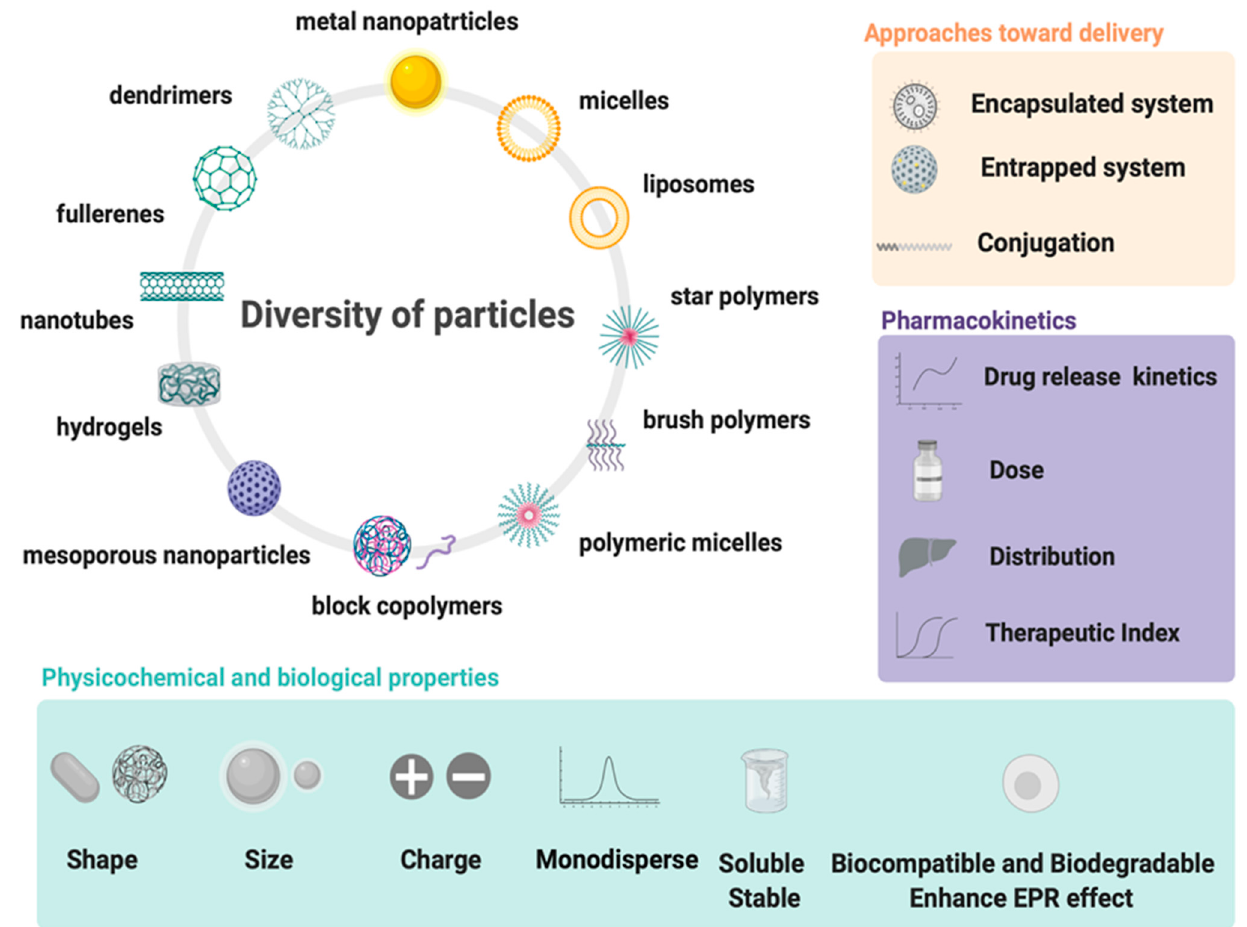
Figure 3. Design and properties requirements for drug delivery systems using wide spectrum of particles.